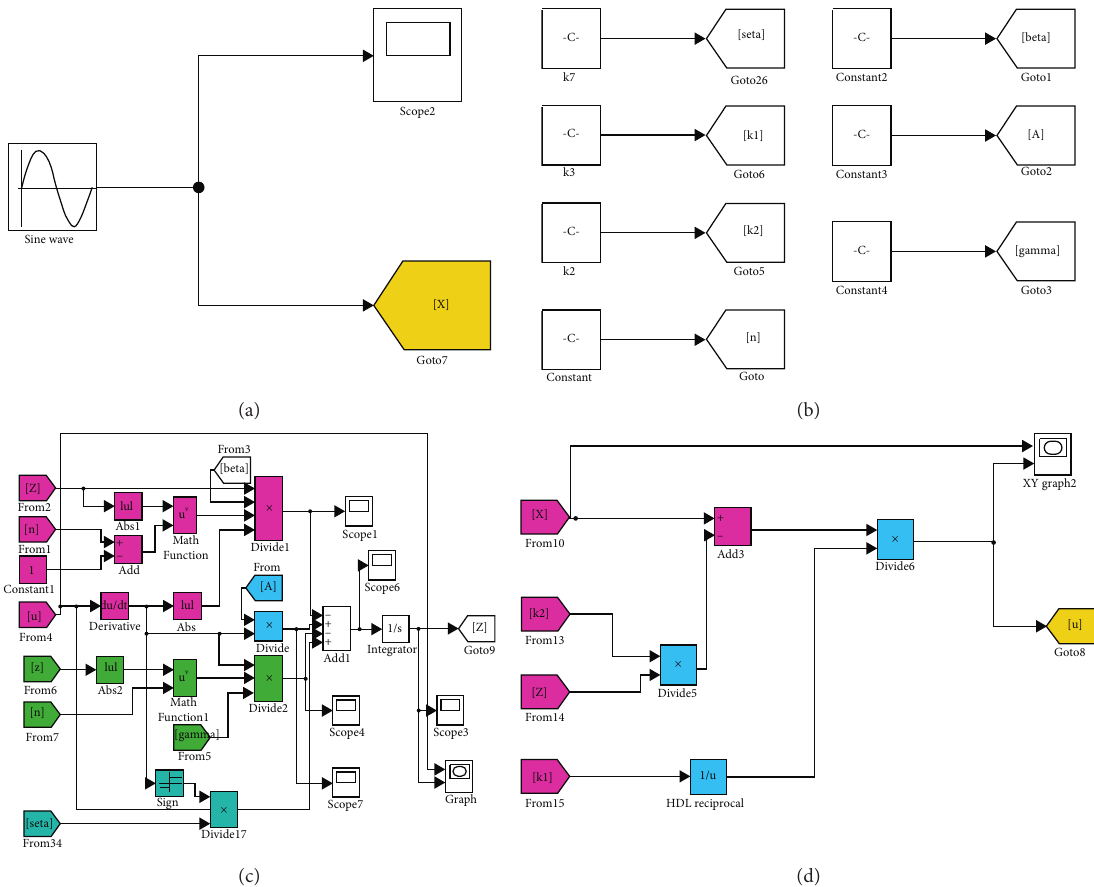
Figure 4: Feedforward controller. (a) Signal input. (b) Model parameter. (c) Hysteresis. (d) Feedforward